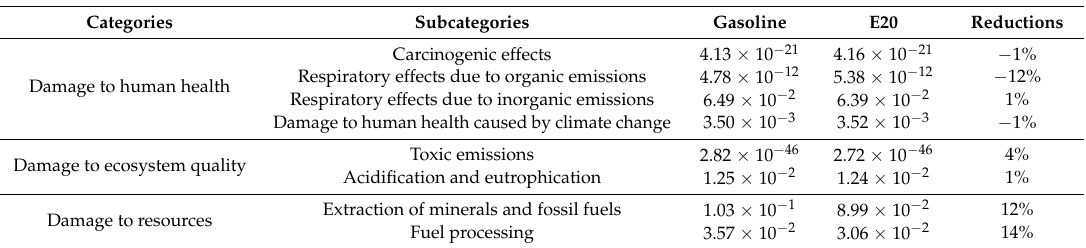
Table 6. Overall environmental impact of using ethanol-gasoline blends in vehicles according to the Eco-indicator-99